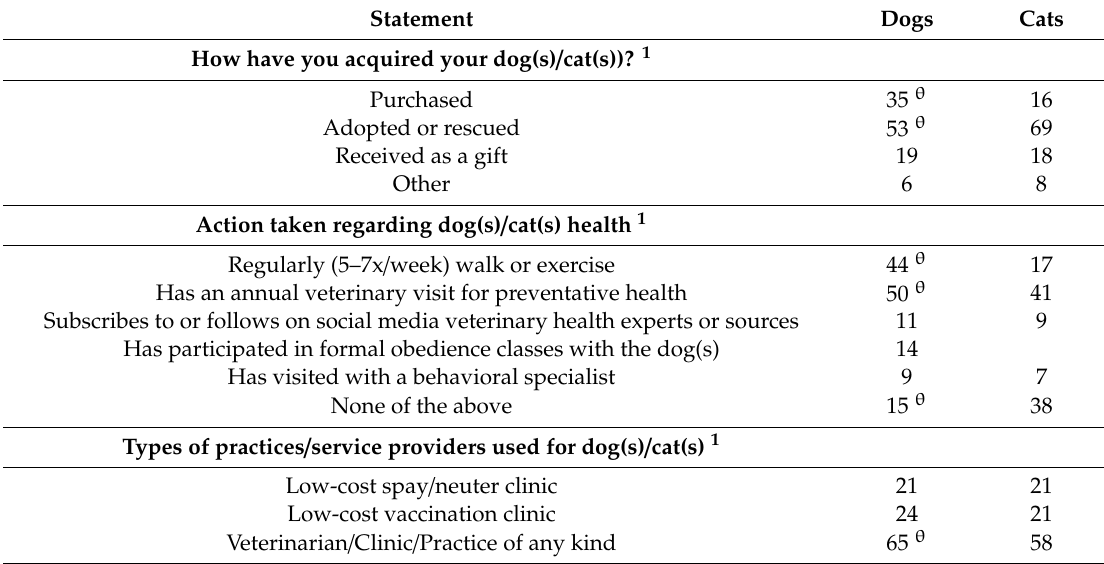
Table 3. Pet-owning respondent pet care and usage of veterinary services. Percent (%) of dog- (n = 477) or cat- (n = 352) owning